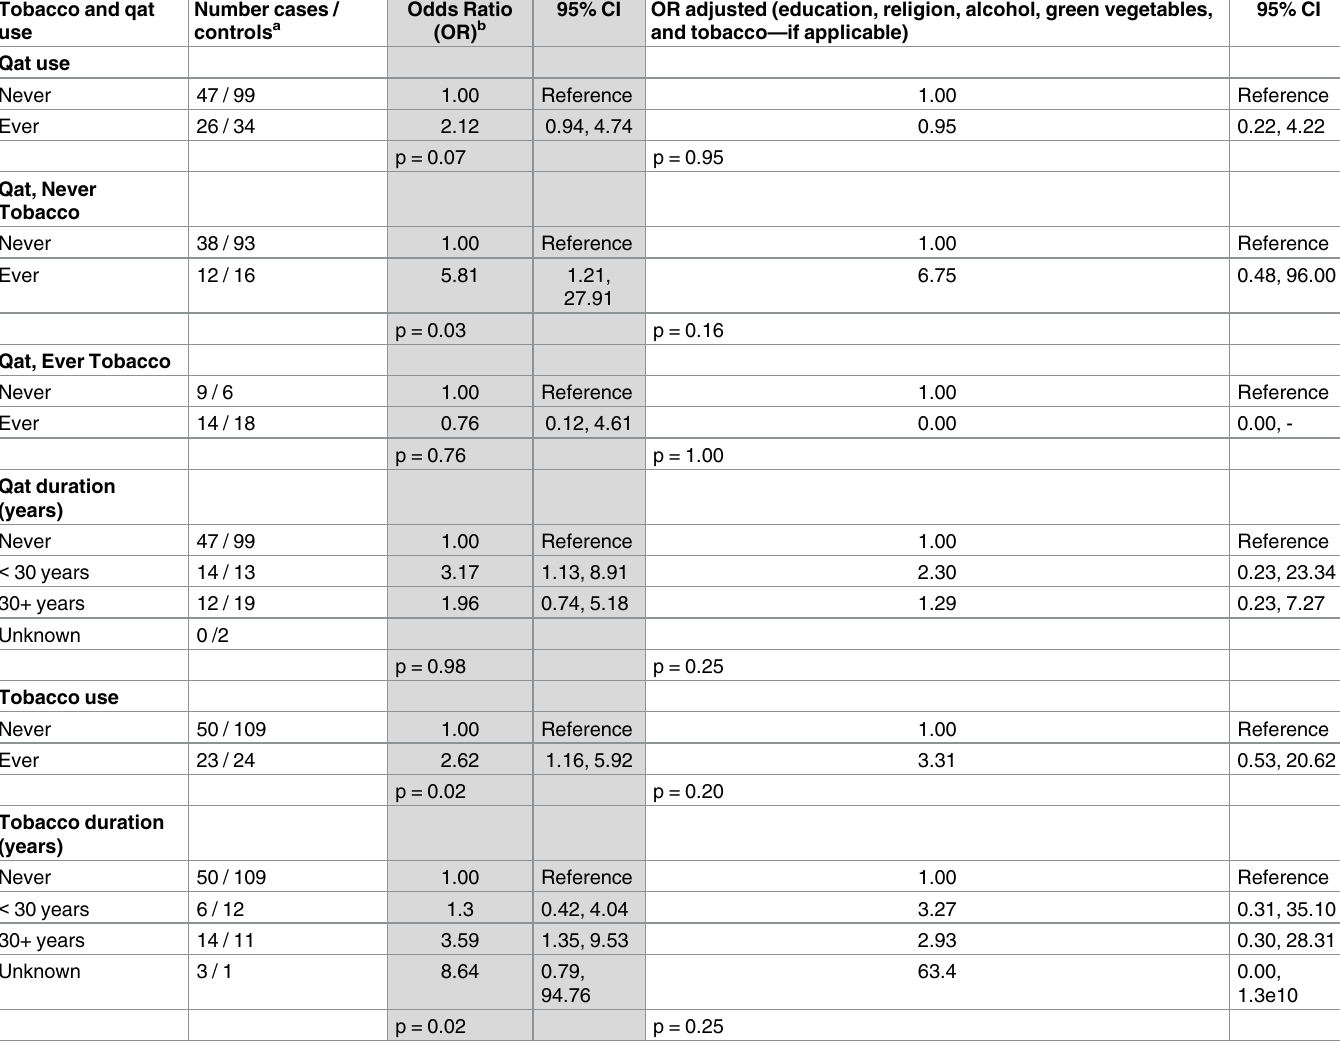
Table 2. Qat and tobacco use and risk of esophageal and gastro-esophageal junction cancerscombined in a pilot case–control study in Addis Ababa. Tobacco and qat